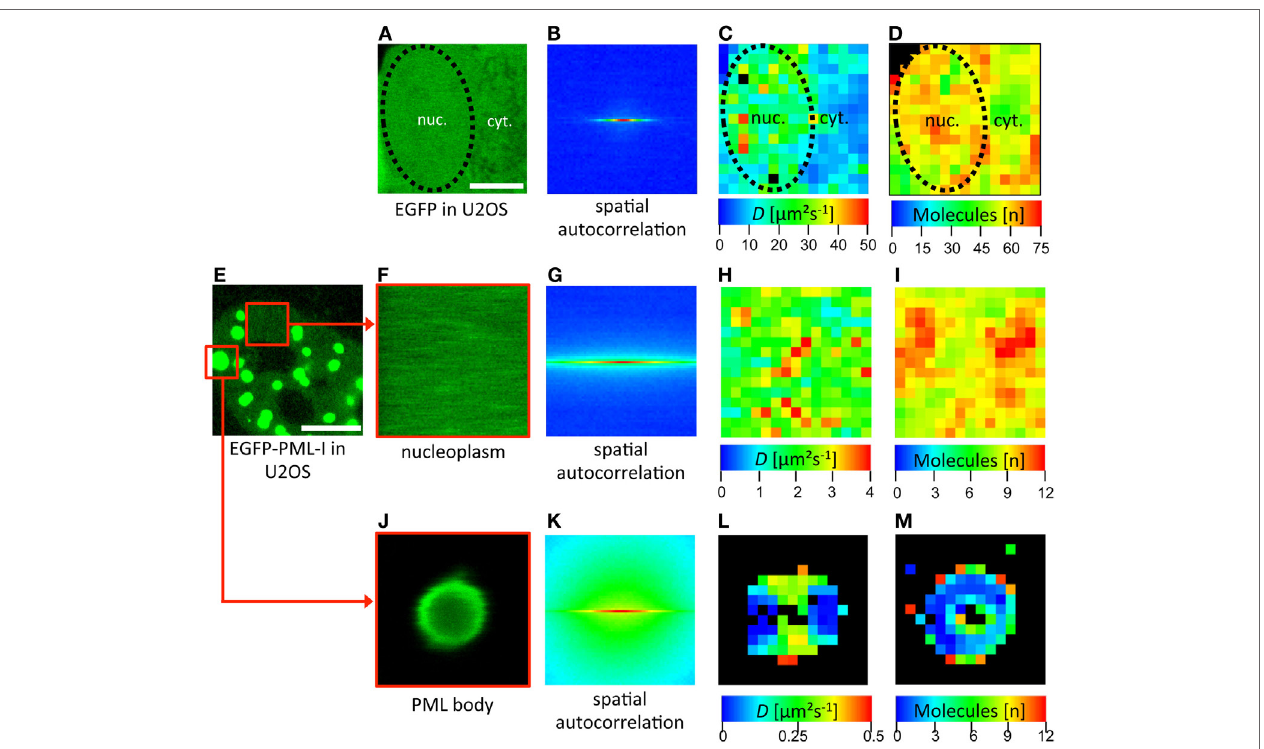
FigURe 6 | Spatial mapping of promyelocytic leukemia (PML) protein mobility in the nucleus by raster image correlation spectroscopy (RICS). (A–D) As an introductory example, RICS was performed in a U2OS cell expressing EGFP alone. (A) Shows a subregion of the cell containing nuclear (nuc.) and cytoplasmic (cyt.) parts. The nuclear outshape is indicated by a black dashed line. For RICS analysis, a time series of GFP fluorescence images was acquired by confocal microscopy. Thus, the fluorescence intensity of each pixel is collected and the spatial autocorrelation is obtained per image (B) . The image stack serves to increase the SNR and to be able to remove immobile and slow molecules. This analysis generates spatial maps of the diffusion coefficient (C) and the number of free molecules which contributed to the assessment (D) . Since the shape of the spatial autocorrelation image indicates mostly freely diffusing species, the RICS data were fitted with a one-component 3D-free diffusion model yielding diffusion coefficients for EGFP in the nucleus between 10 µm 2 s − 1 and 50 µm 2 s − 1 (C) . RICS was then performed similarly in a EGFP-PML-I-expressing U2OS cell (e–M) . In the nucleoplasm, the diffusion coefficient of EGFP-tagged PML-I ranged between 1 µm 2 s − 1 and 4 µm 2 s − 1 (H) . RICS in a region containing a large PML NB (J) still delivered acceptable spatial autocorrelation quality (K) . This approach revealed a diffusion coefficient of EGFP-PML-I in or at PML bodies which was one order of magnitude lower than in the nucleoplasm (L) . Bars; 5